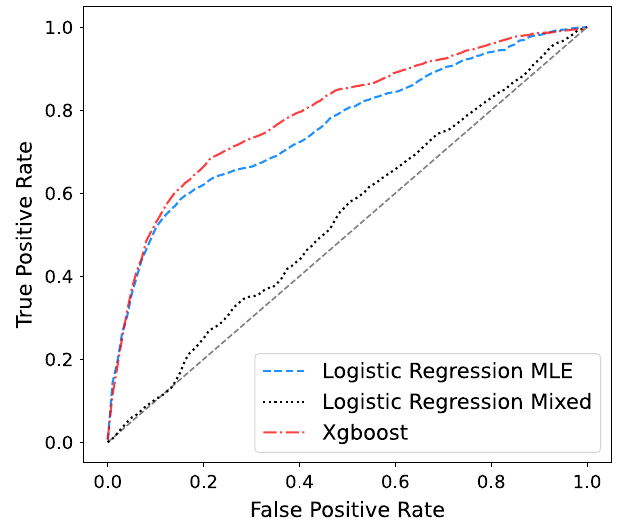
FIG. 5. Receiver operator characteristic curves for the E-CLASSmodelspredictingwhetherastudentisinanintroductory course or a BFY course. The more area under a curve, the better its performance. Overall, the boosted model (AUC ¼ 0 . 798 ) per- forms approximately 2% better than the maximum likelihood model (AUC ¼ 0 . 773 ) and considerably better than the mixed effects model (AUC ¼ 0 . 581 ). However, the overall scores are still below an excellent discrimination (AUC > 0 . 8 ) as identified by Hosmer Jr et al. [68]. In thisfigure, the curves represent the average ROC curve for all 5 cross